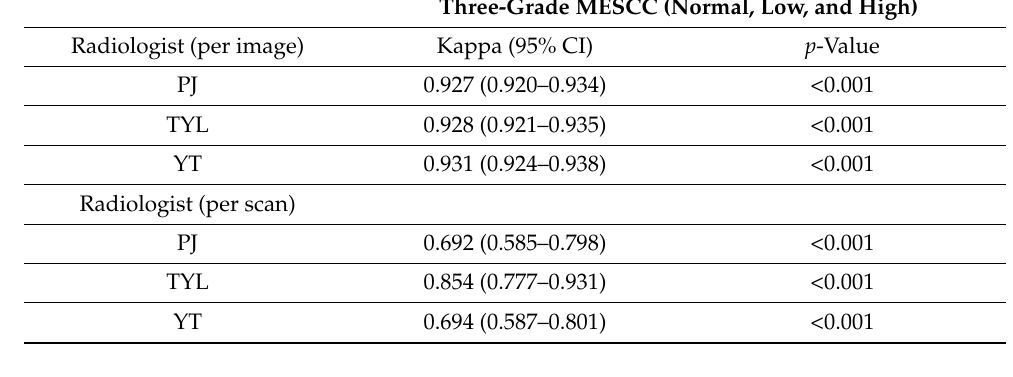
Table 5. Radiologist interobserver variability for three-grade MESCC classification on CT.